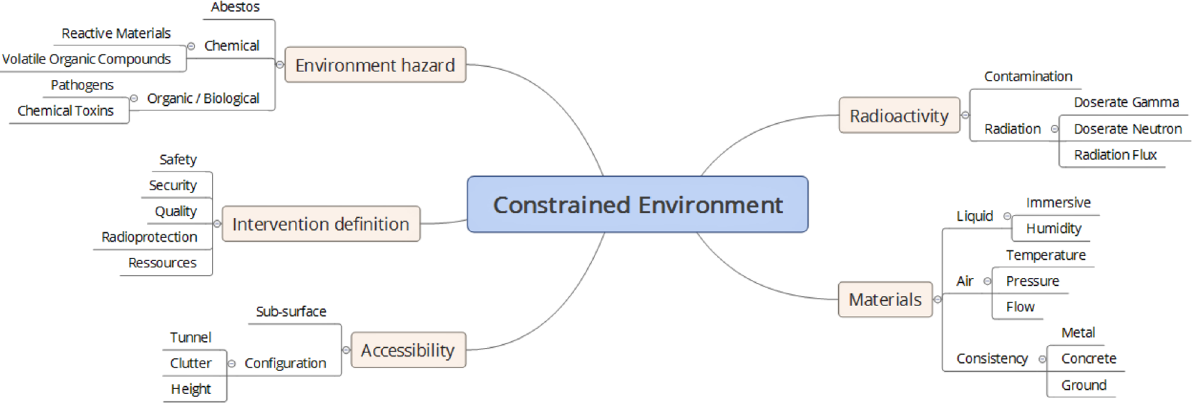
Fig. 4. Constrained